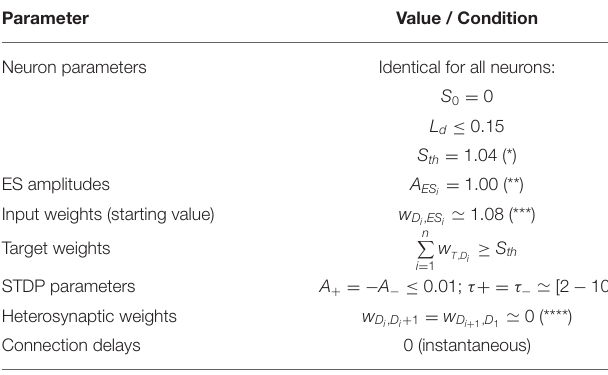
TABLE 1 | Recommended values for the nMNSD structure parameters (see the reference paper Susi et al., 2018).